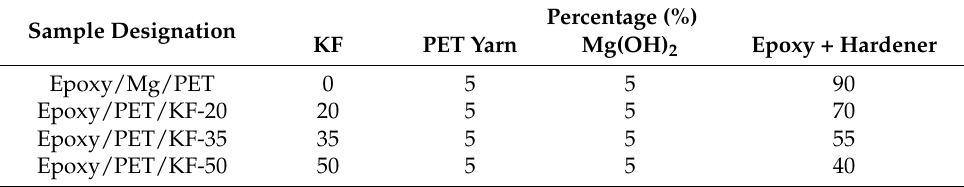
Table 3. Composition of